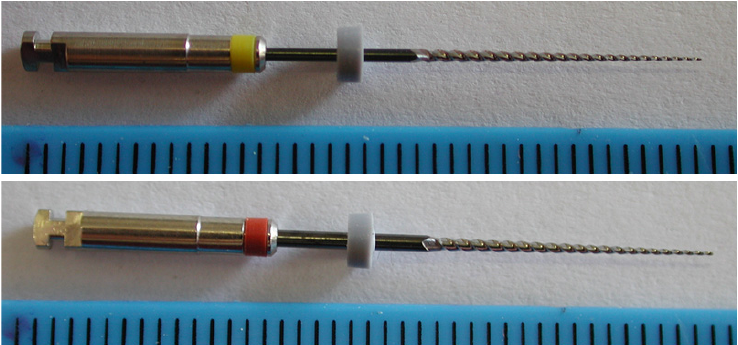
Figure 1: Investigated MICRO-MEGA HERO642 rotary instruments.